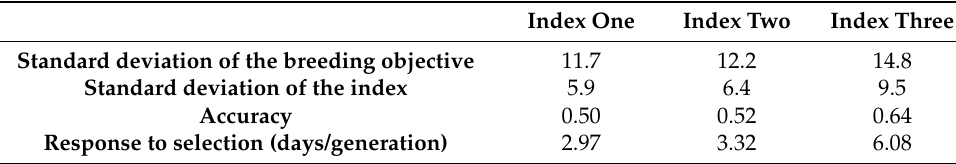
Table 13. Index values were calculated for three different scenarios using index theory, including breeding objective, the variance of the index, accuracy and response to selection. The response units are days per